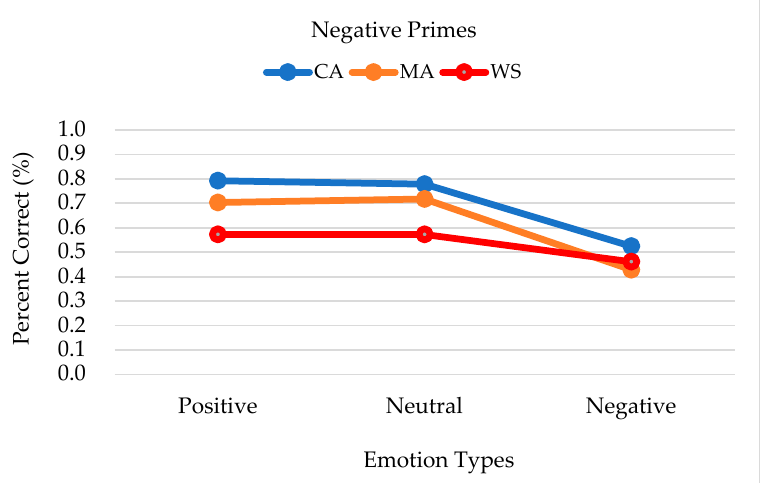
Figure 3. Accuracy of the responses to negative primes by each emotion target type and group. Note. CA, chronological age-matched controls; MA, mental age-matched controls; WS, participants with Williams syndrome.